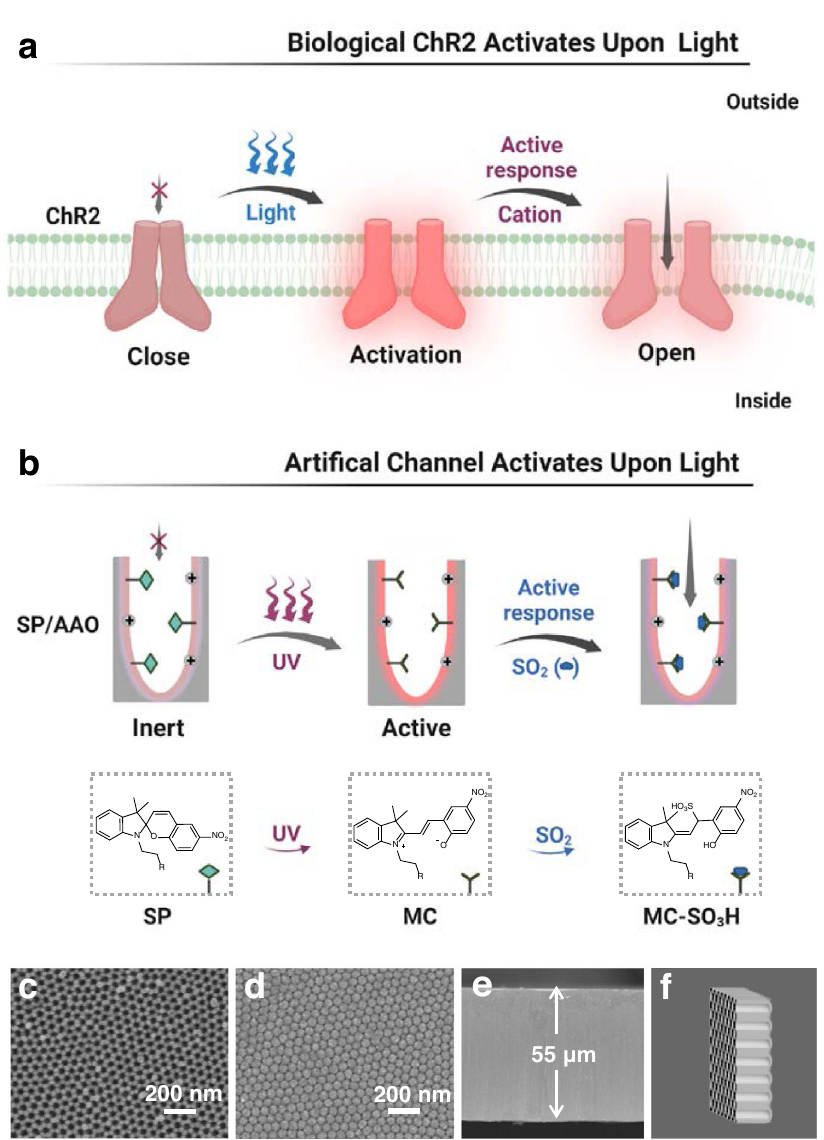
Fig. 1 | Schematic illustration of the ChR2-inspired light-controlled nano- channel sensor with inert/active-switchable reactivity for on-demand detec- tion of SO 2 and the chemical structures of the probes. a Biological ChR2 activation upon light exposure. b Biomimetic SP/AAO nanochannels with UV- controlled inert/active-switchable response to SO 2 . Figure 1a, b was created with